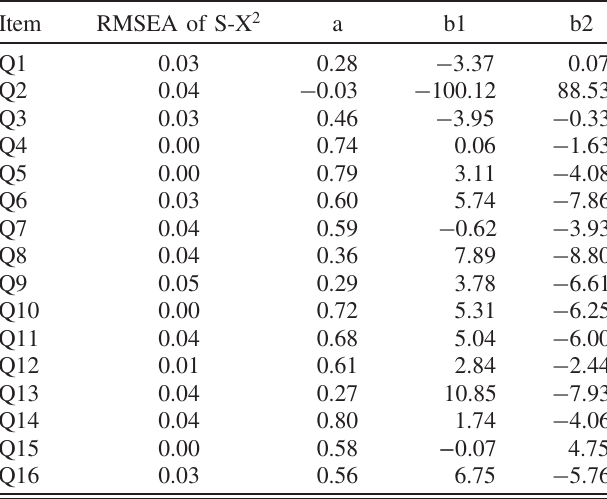
TABLE IV. RMSEA values of the S-X 2 item index fit and item parameters for the IRT model.